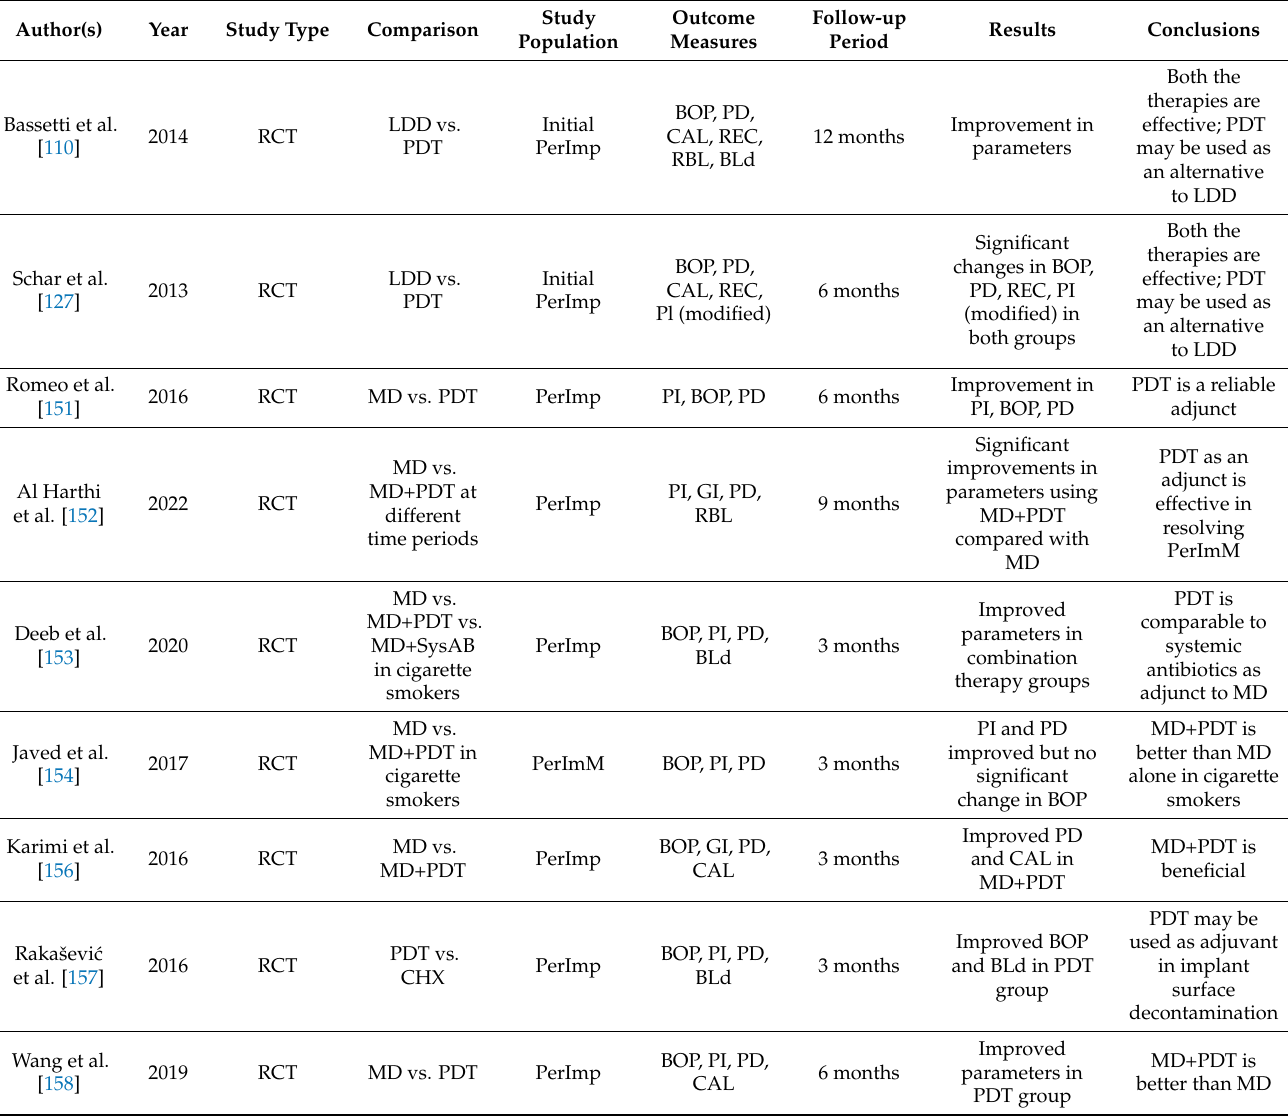
Table 1. Summary of Randomized Controlled Trials of PDT as an adjunctive therapy in peri- implant